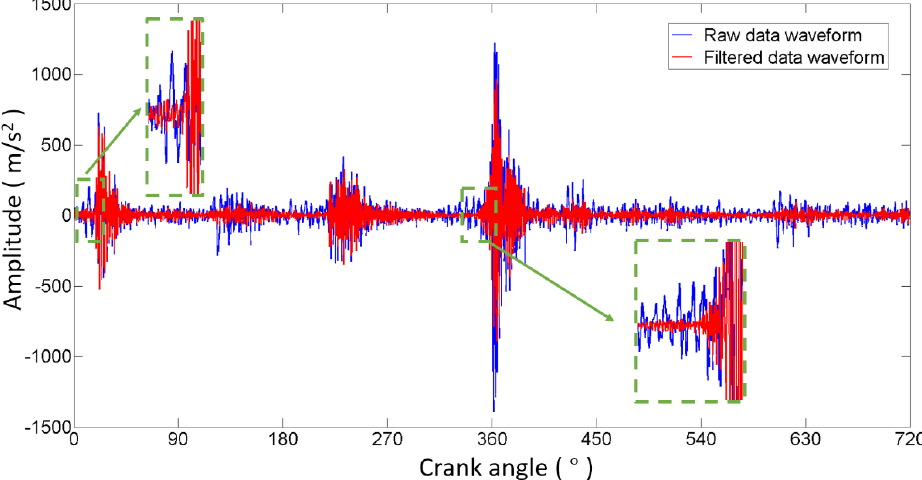
REST in the frequency domain.